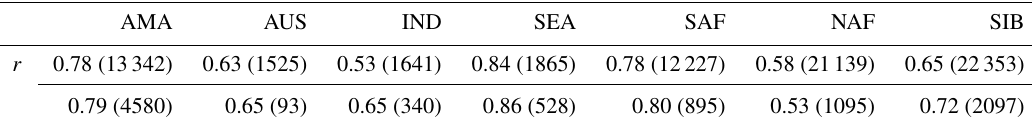
Table 1. Upper row: correlation coefficients between the HCOOH total columns and the CO total columns measured by IASI for the period between 2008 and 2014 over the seven studied regions. Lower row: as upper row but with only MODIS fire hotspot having a surface wind speed lower than 1.44ms − 1 . Each IASI datapoint is selected in an area of 50km around the MODIS fire hotspot and up to 5h after the time recorded for each fire. The number of fires characterized by HCOOH and CO total columns is given in parenthesis.